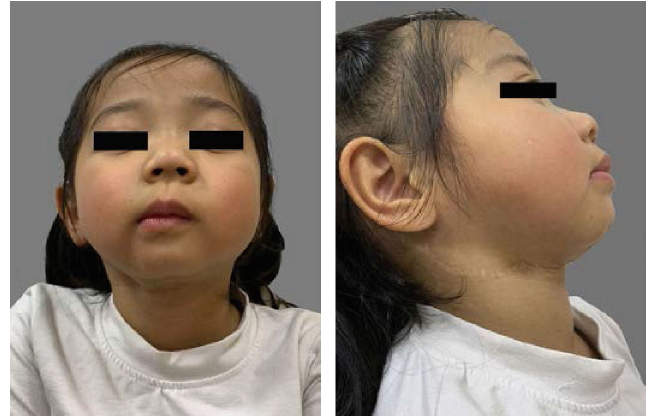
Figure 5: Photographs of the patient at 2-year